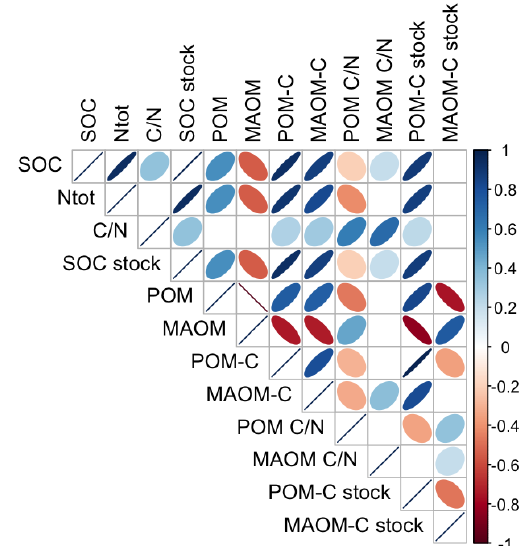
Figure 2. Correlation matrices of bulk soil and fractions POM and MAOM. Blue ellipses indicate a positive correlation and red a negative correlation. The narrower the ellipse and the more intense its color, the stronger the correlation. The direction of the ellipse depends on the color.